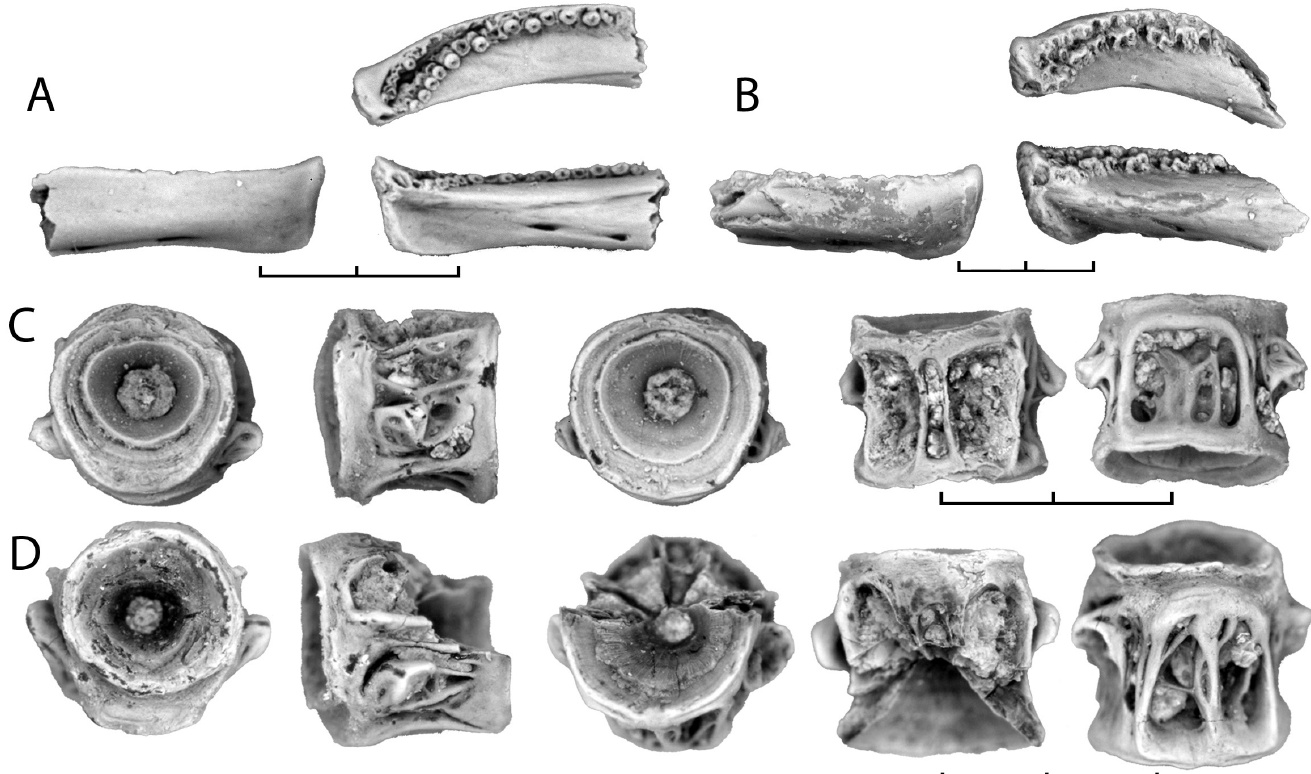
Figure 19. Esocoid elements from the Milk River Formation. A-B) dentaries of Estesesox foxi showing variation in the development of the tooth row: A dentary showing the presence of two rows of teeth at the anterior end of the tooth row, UALVP 56048b; B, dentary show - ing more extensive development of multiple tooth rows and more robust inner surface, UALVP 25653b. C – D) esocoid precaudal centra: C, UALVP 56048; D, UALVP 48866. Centra shown in anterior, left lateral, posterior, dorsal and ventral views. Scale bar equals 2